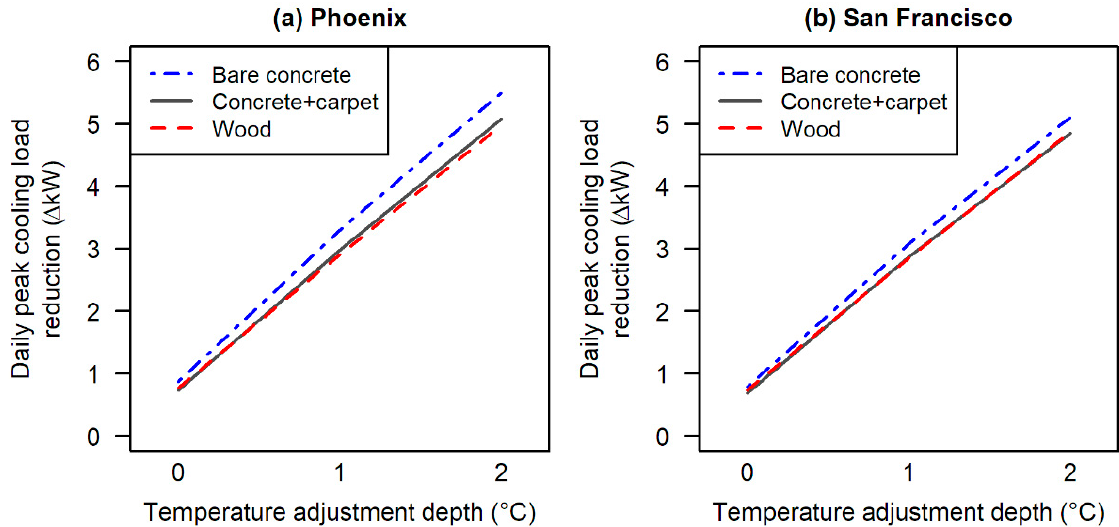
Figure 11. A median value of the daily peak cooling load reductions during 106 weekdays from 1 June to 31 October with respect to the GTA depth for three floor configurations: Bare concrete, Concrete + carpet, and Wood in ( a ) Phoenix, AZ and ( b ) San Francisco, CA.